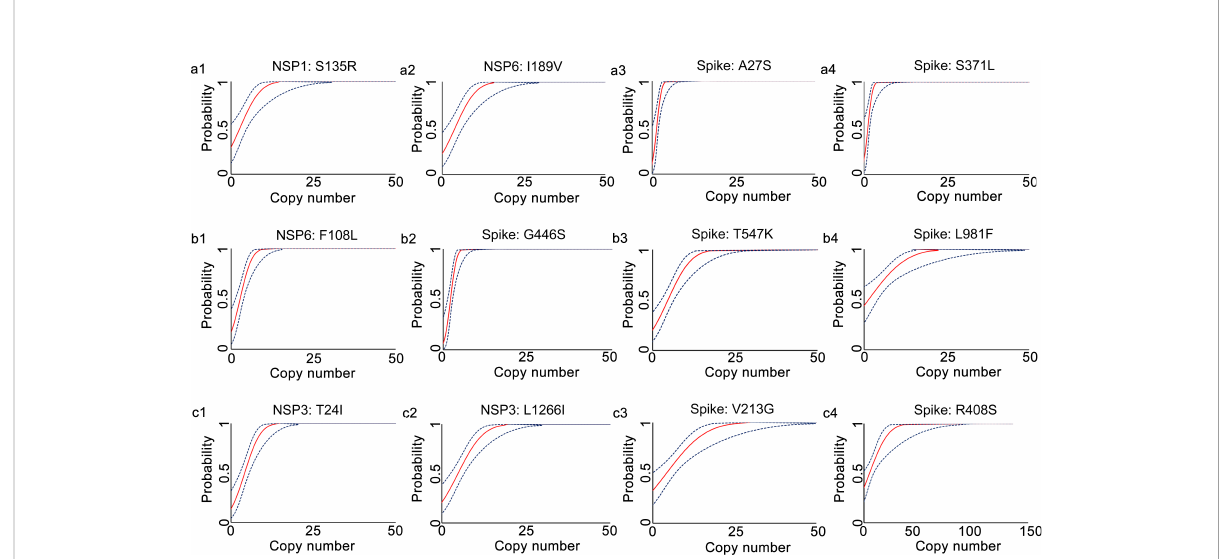
FIGURE 2 Determination of limits of detection for the developed multiplex allele-speci fi c qRT-PCR assays to detect the prototype RNA of SARS-CoV-2. Limits of detection (LoDs) for the developed qRT-PCR assays to detect the prototype RNA of SARS-CoV-2 were determined by the Probit Regression (Dose-Response analysis) implemented in SPSS v22.0. qRT-PCR was performed by using the in vitro transcribed viral prototype RNA (2-fold dilution from 200 copies/reaction to 0.1 copies per reaction) as templates. The obtained Cp values and the corresponding copy number of viral RNA were applied for Probit Regression analysis. Probit curves for assay 1 [NSP1: S135R (a1), NSP6: I189V (a2), Spike: A27S (a3), and Spike: S371L (a4)], assay 2 [NSP6: F108L (b1), Spike: G446S (b2), Spike: T547K (b3) and Spike: L981F (b4)], assay 3 [NSP3: T24I (c1), NSP3: L1266I (c2), Spike: V213G (c3), and Spike: R408S (c4)] are shown. The inner solid line (in red) is a Probit curve. The outer dotted lines (in dark blue) are 95%